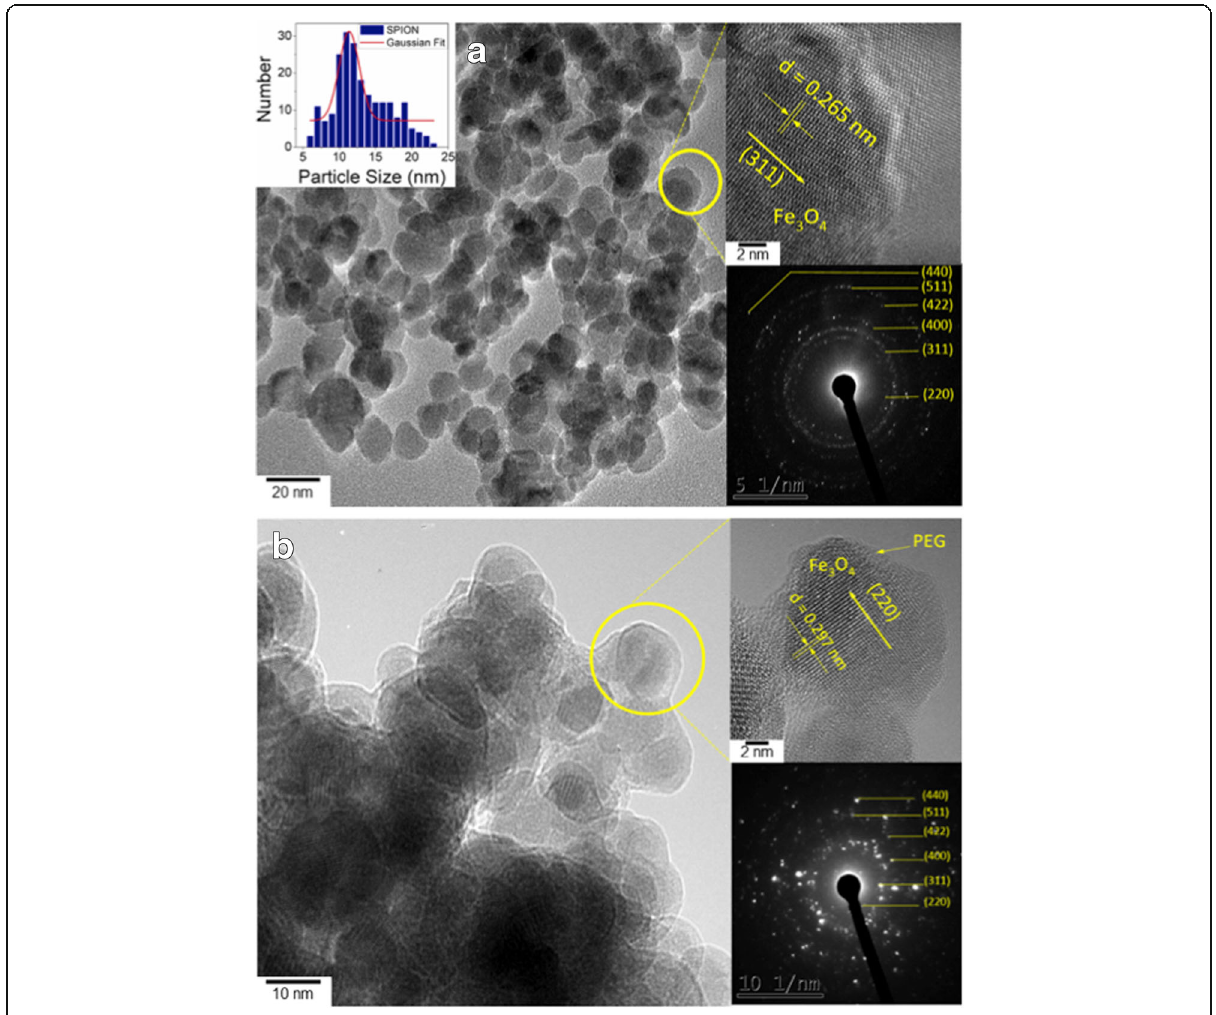
Fig. 3 a Bright field HRTEM images of bare Fe3O4 nanoparticles (SPION). The top left and right and bottom left insets show the average crystal size distribution, close-up and the SAED pattern of SPION, respectively. b Bright field HRTEM images of PEGylated Fe3O4 nanoparticles (PEG-SPION). The top left and right and bottom left insets show the average crystal size distribution, close-up, and the SAED pattern of PEG-SPION,